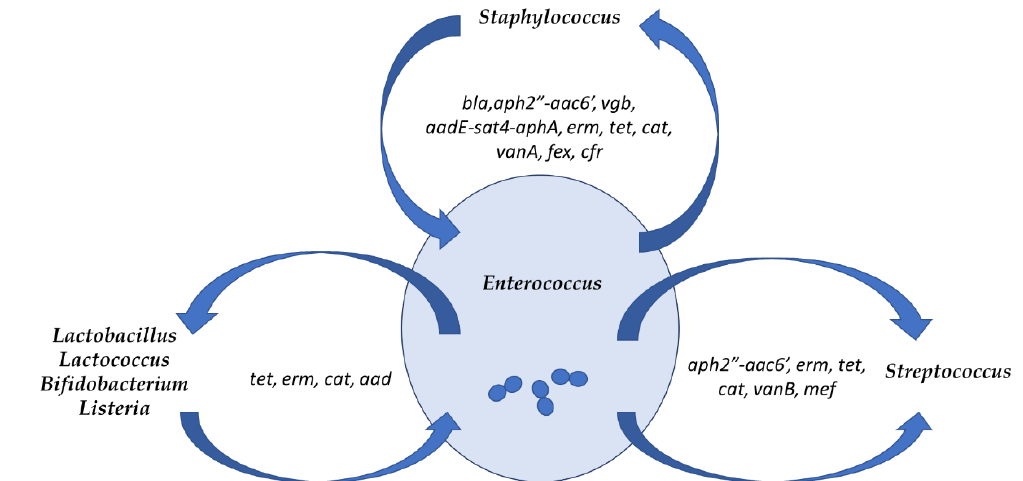
Figure 3. Shared genetic determinants of antibiotic resistance between enterococci and other bacteria that occupy the same habitats, with indication of the main genetic determinants of resistance shared; tet refers to either tetK , L , M, O , and/or W , and erm refers to ermA, B and/or C. (Data for this figure were obtained from Werner et al. [5]).